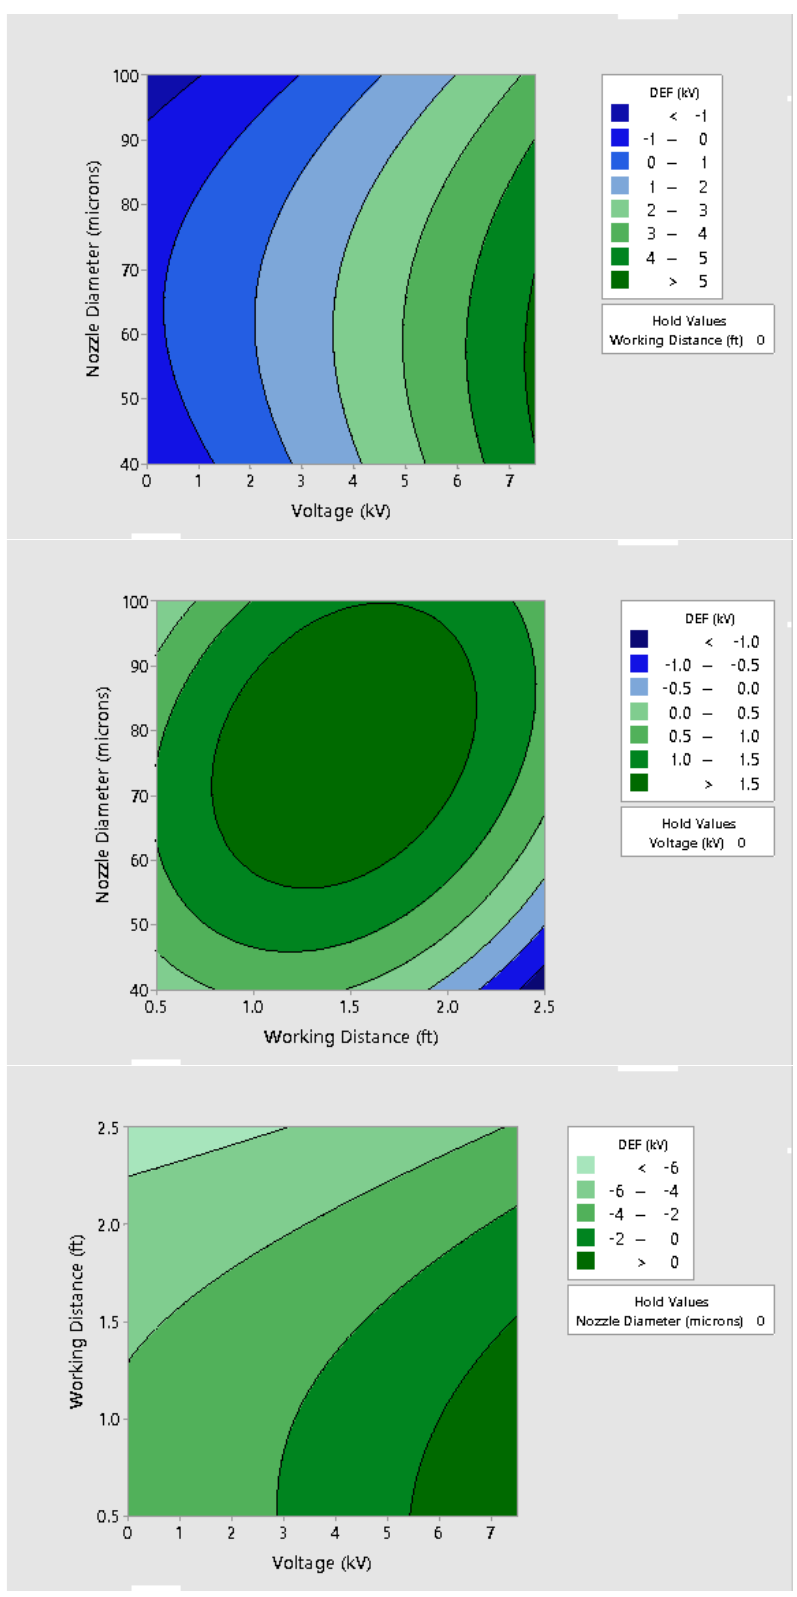
Figure A18. Polypropylene: quantitative representation of average differential electric field vs. working distance (feet), nozzle sprayer size ( µ m), and charge voltage